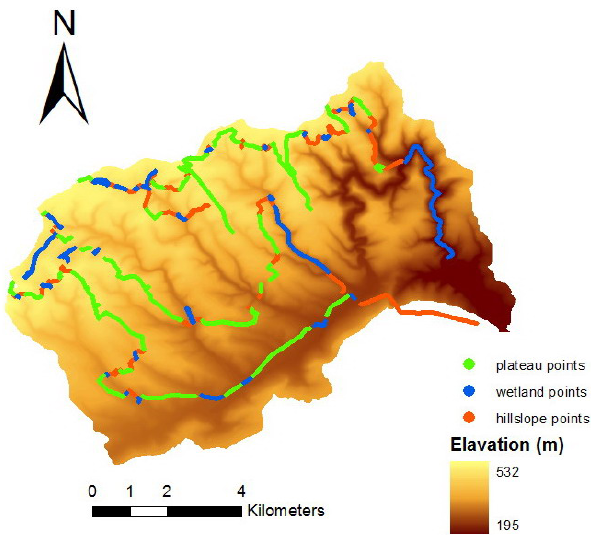
Fig. 2. Observation points in the Wark Catchment and their corre- sponding landscape classes.